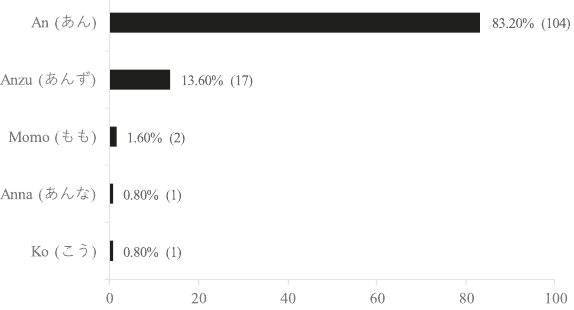
Fig. 8 Variations in readings of the name 杏 . Scores indicate relative frequencies of each reading among the sample ( n = 125). Scores in parentheses indicate the absolute frequencies of each